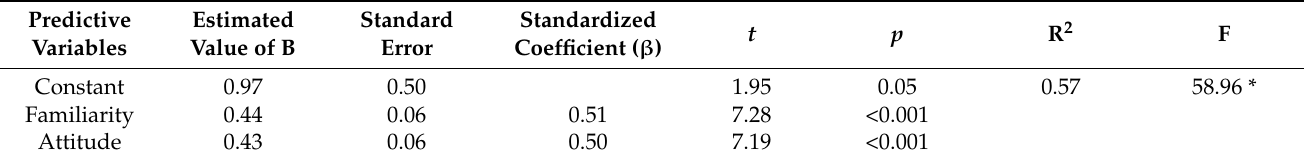
Table 4. Analysis of the factors affecting CHPs’ level of confidence in implementing HL